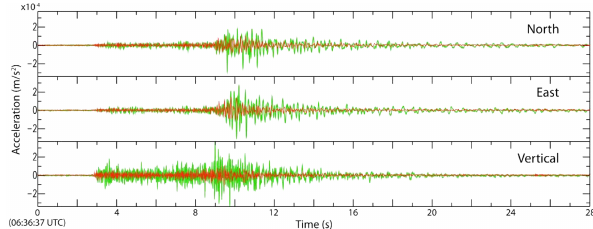
Figure 4. Comparison between waveforms of the M l = 2 . 7 18 February 2011 Potenza earthquake recorded inside the landslide body (green curve, accelerometric station C) and on the bedrock (red curve, accelerometric station